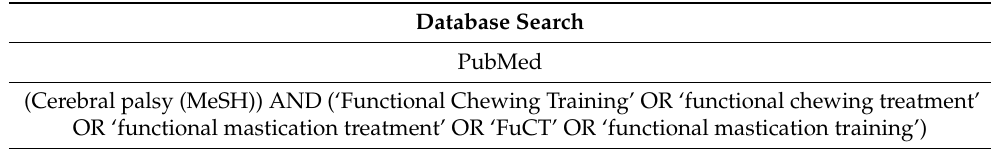
Table 1. Search of four